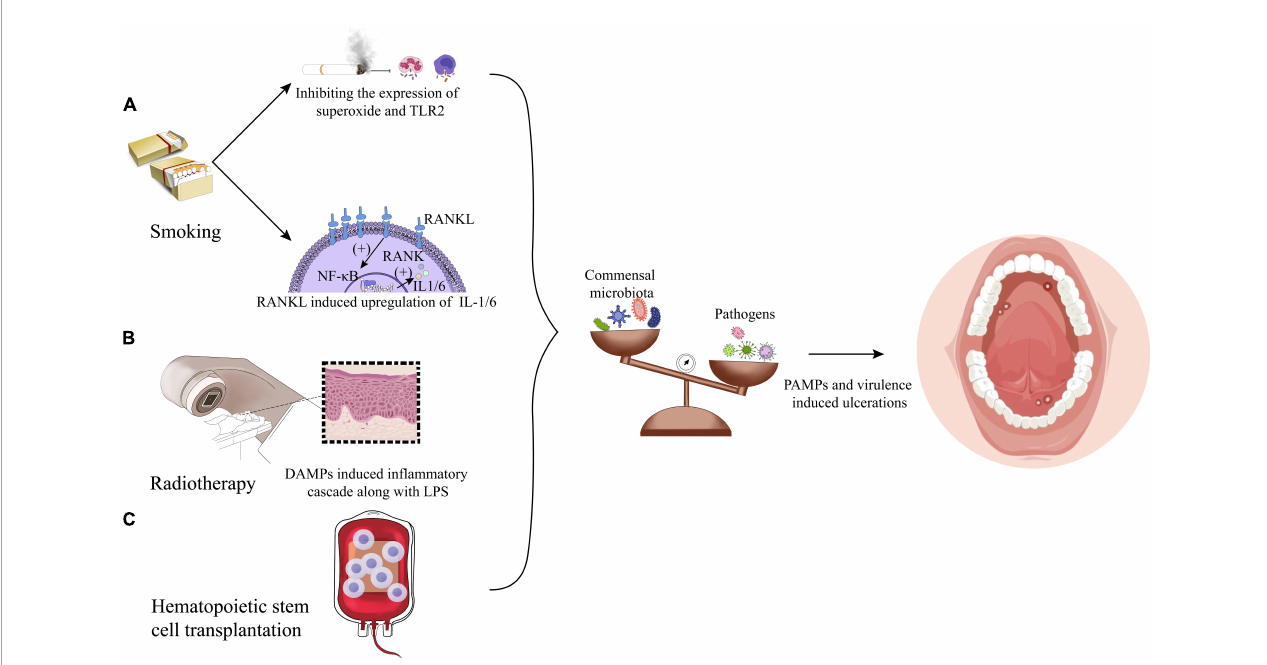
FIGURE2 Factors leading to the microbiota shifts: (A) smoking exerts a significant influence on dysbiosis by microbiota carried by immune reaction inhibition and upregulation of IL-1/6 induced by receptor activator of nuclear factor- κβ Ligand (RANKL). (B) Radiotherapy could initiate oral mucositis induced by damage-associated molecular patterns (DAMPs) along with lipopolysaccharide (LPS). (C) Hematopoietic stem cell transplantation impacts the flora alterations in a way